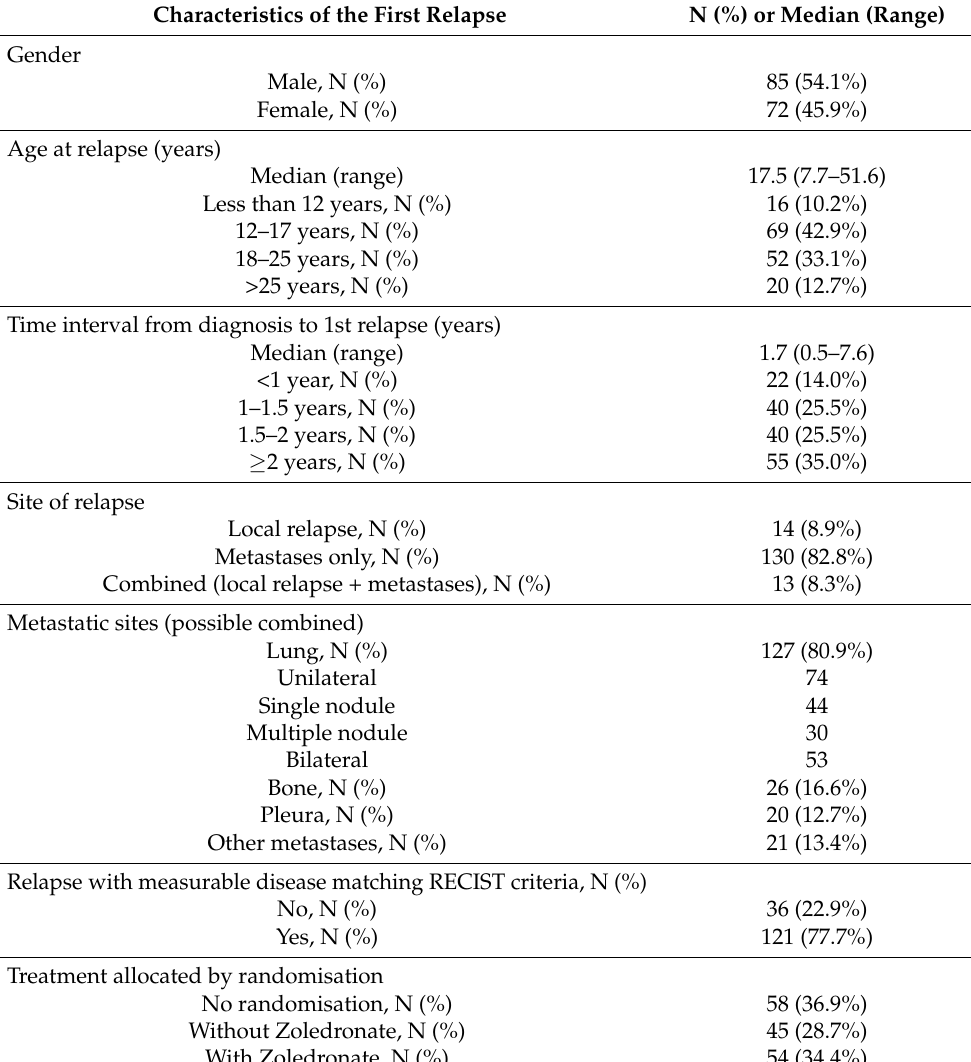
Table 1. Characteristics of patients and tumour at first relapse (157